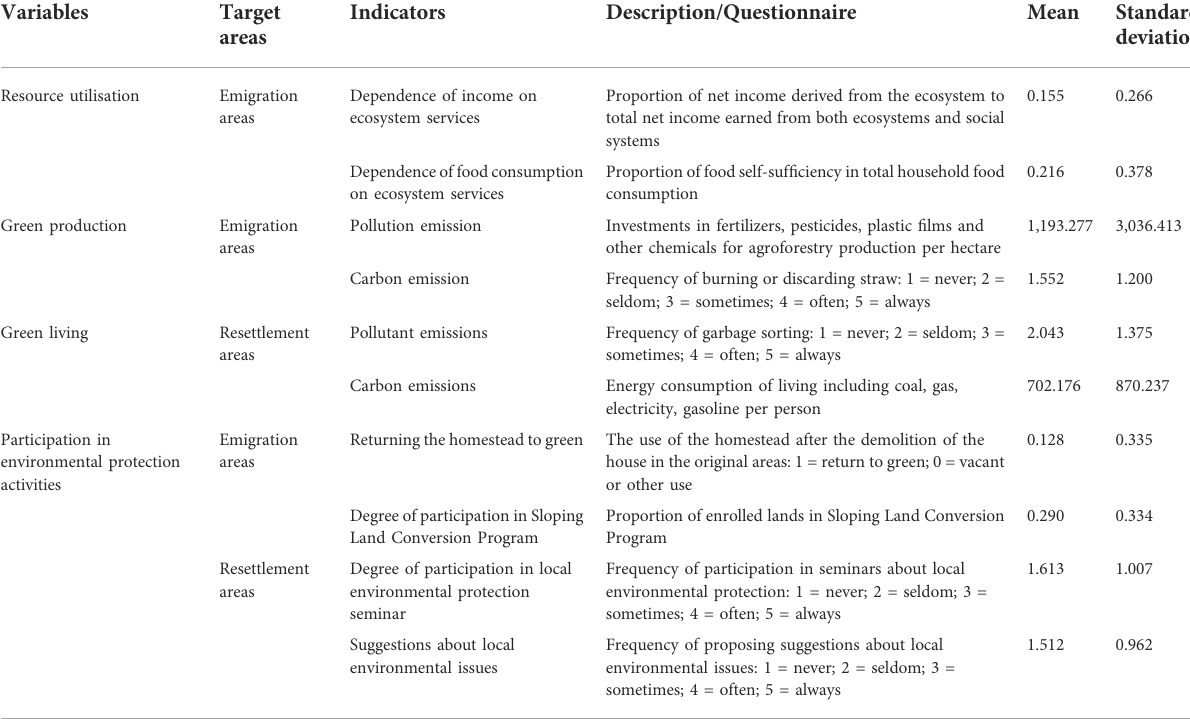
TABLE 2 Variable design and statistics for pro-environmental